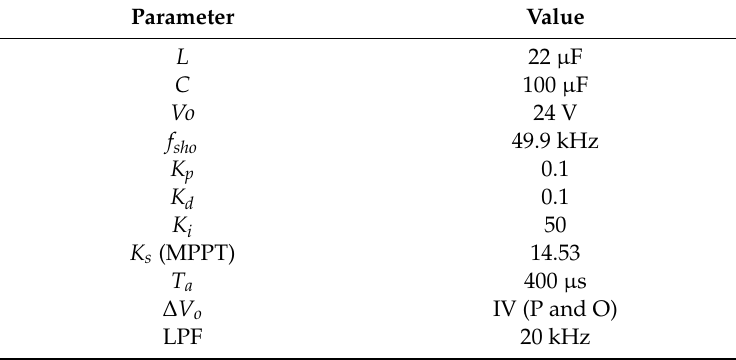
Table 2. Parameters of controller, converter, and maximum power point tracking